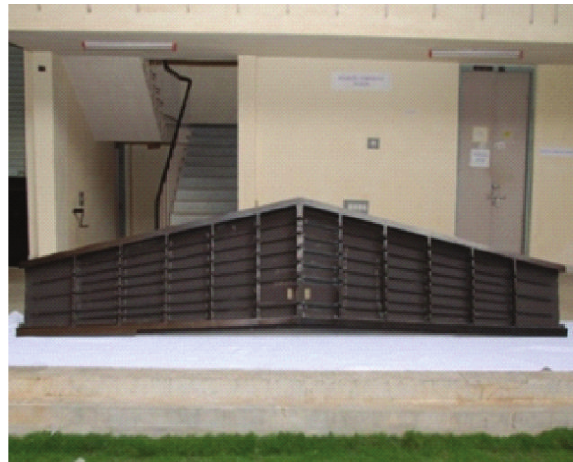
Figure 14: HT of SARAS aircraft, which was cured in an autoclave at CSIR-NAL.